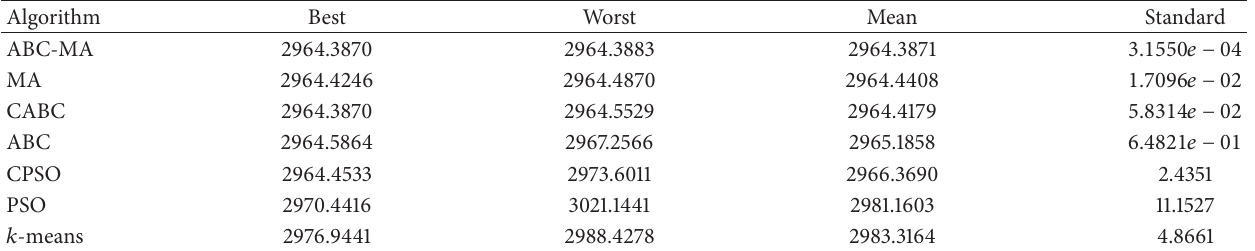
Table 11: Results obtained by the algorithms for 20 different runs on cancer data.